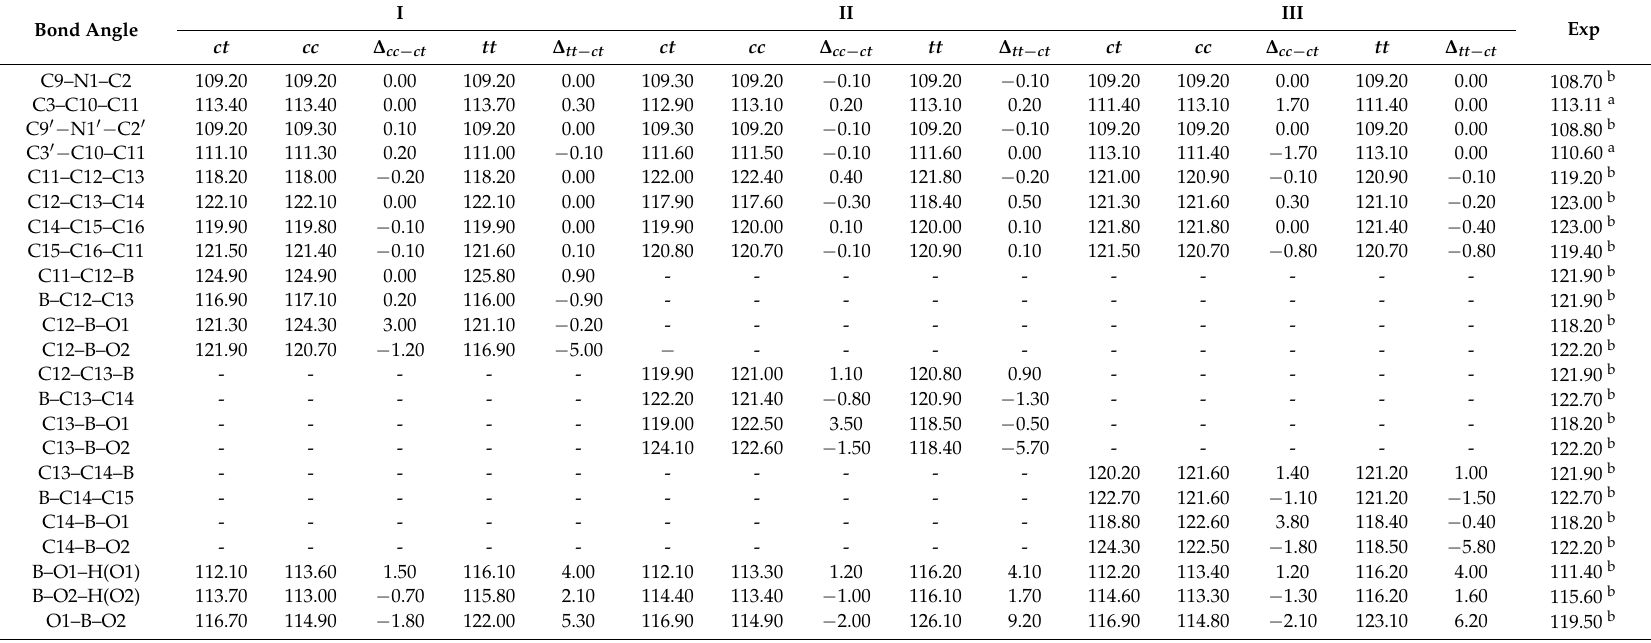
Table 5. Selected theoretically and experimental bond angles ( ◦ ) of the conformers of the target